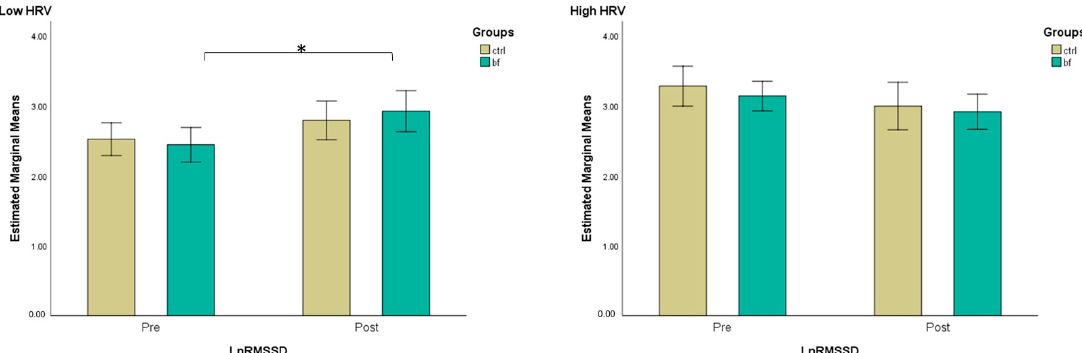
Figure 4. Estimated marginal means (with 95% confidence intervals) for ln RMSSD pre ‐ and post ‐ intervention across groups, separated by low and high RMSSD level at baseline (*— p < 0.05—T ‐ test for dependent samples).